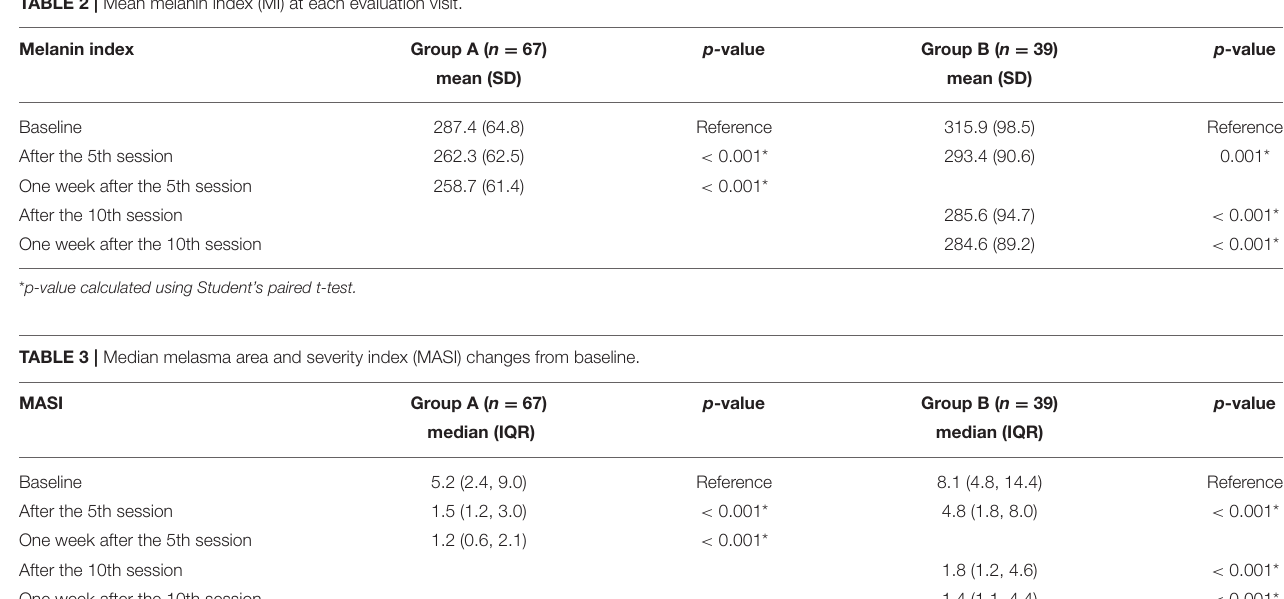
TABLE 2 | Mean melanin index (MI) at each evaluation visit.